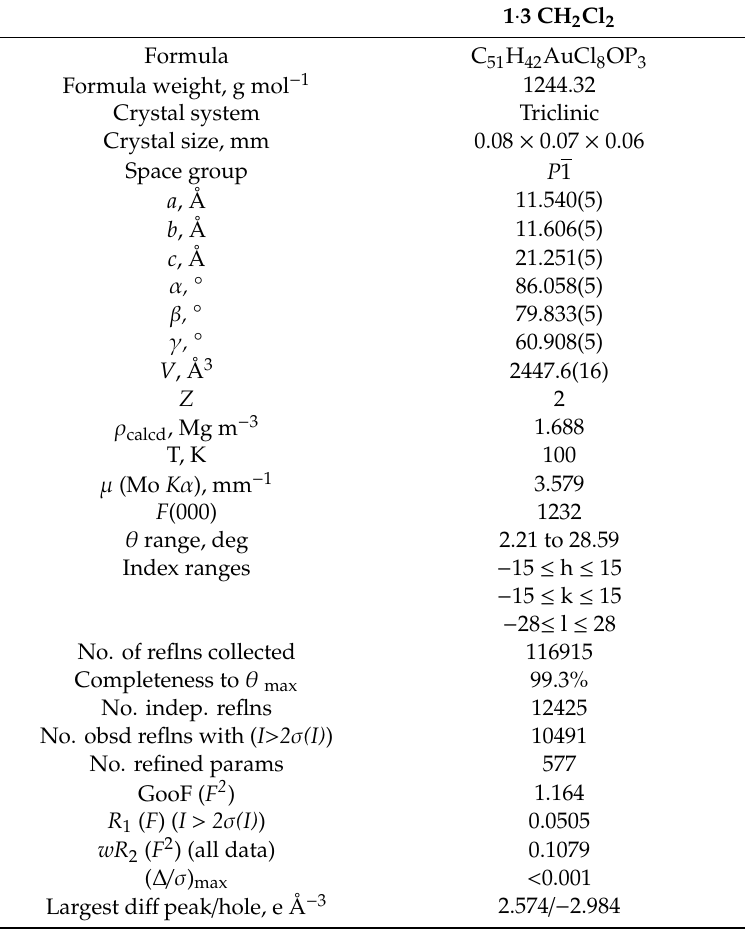
Table 4. Crystal data and structure